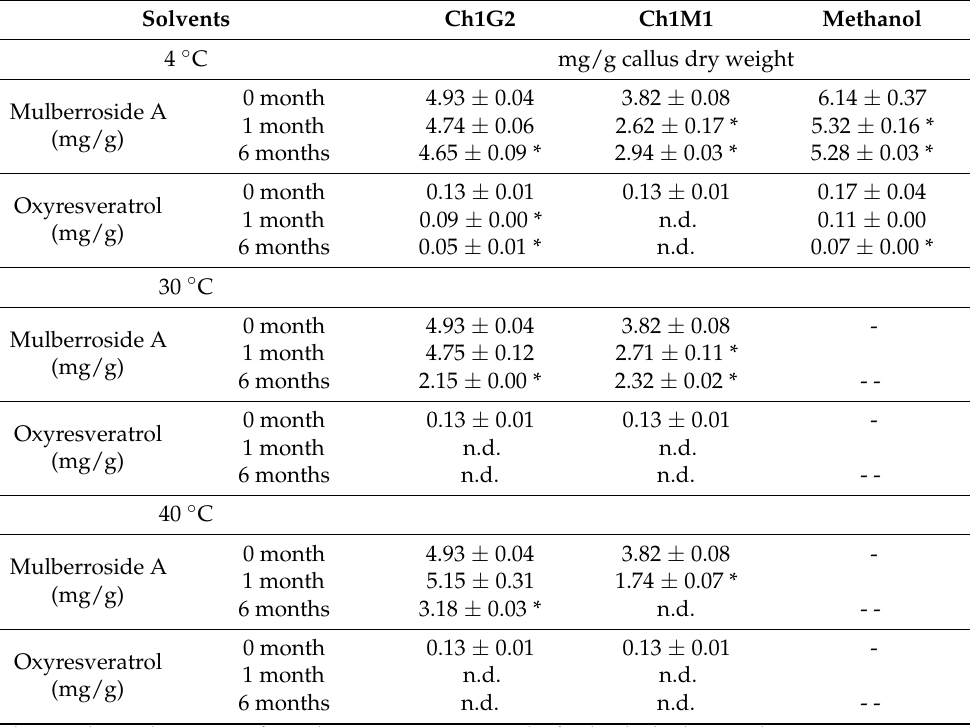
Table 3. The stability of stilbenoids in MA extract using NADES and methanol at varying tempera- tures for 1 and 6 months (mean ± SD, n = 3). Solvents Ch1G2 Ch1M1 Methanol 4 ◦ C mg/g callus dry